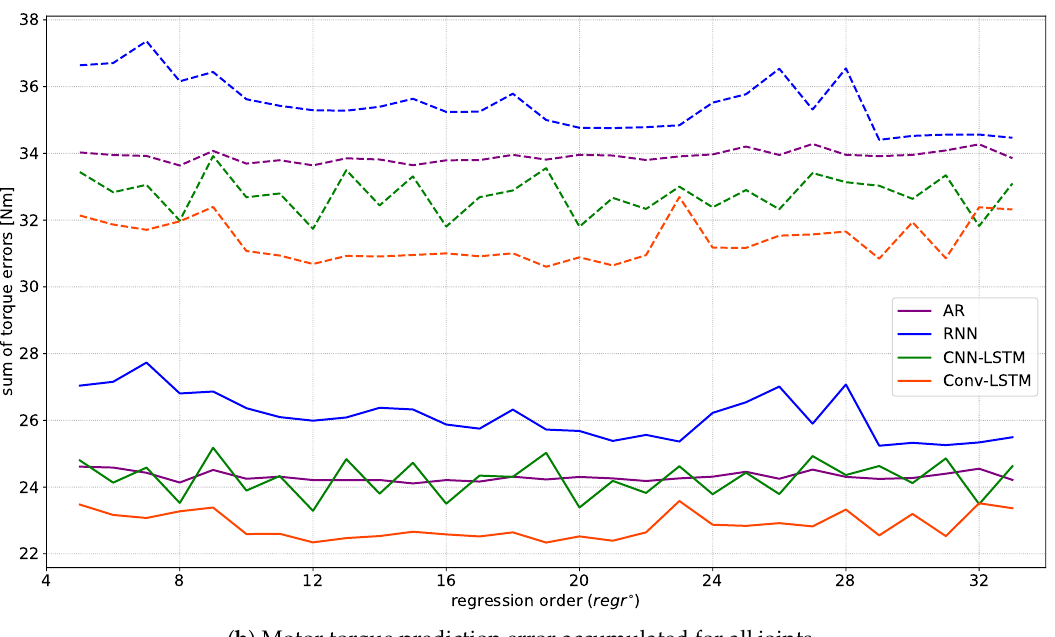
( b ) Motor torque prediction error accumulated for all joints. Figure 4. Experimental results for the mean absolute error—MAE (solid lines) and the root mean-square error—RMS (dashed lines) as a function of the regression order, where the descriptive legend is